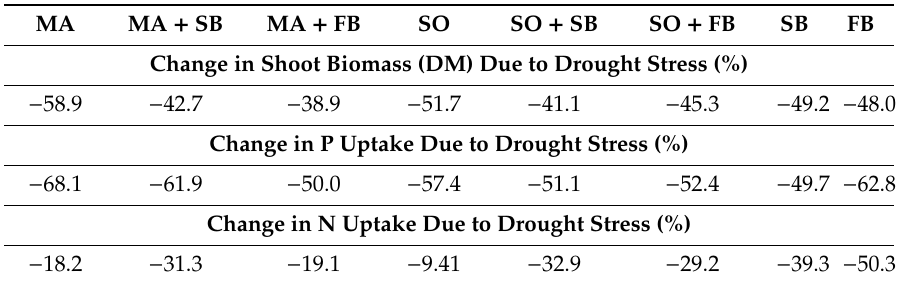
Table A3. Reduction of yield and nutrient uptake in consequence of drought in the Water-Trial. MA